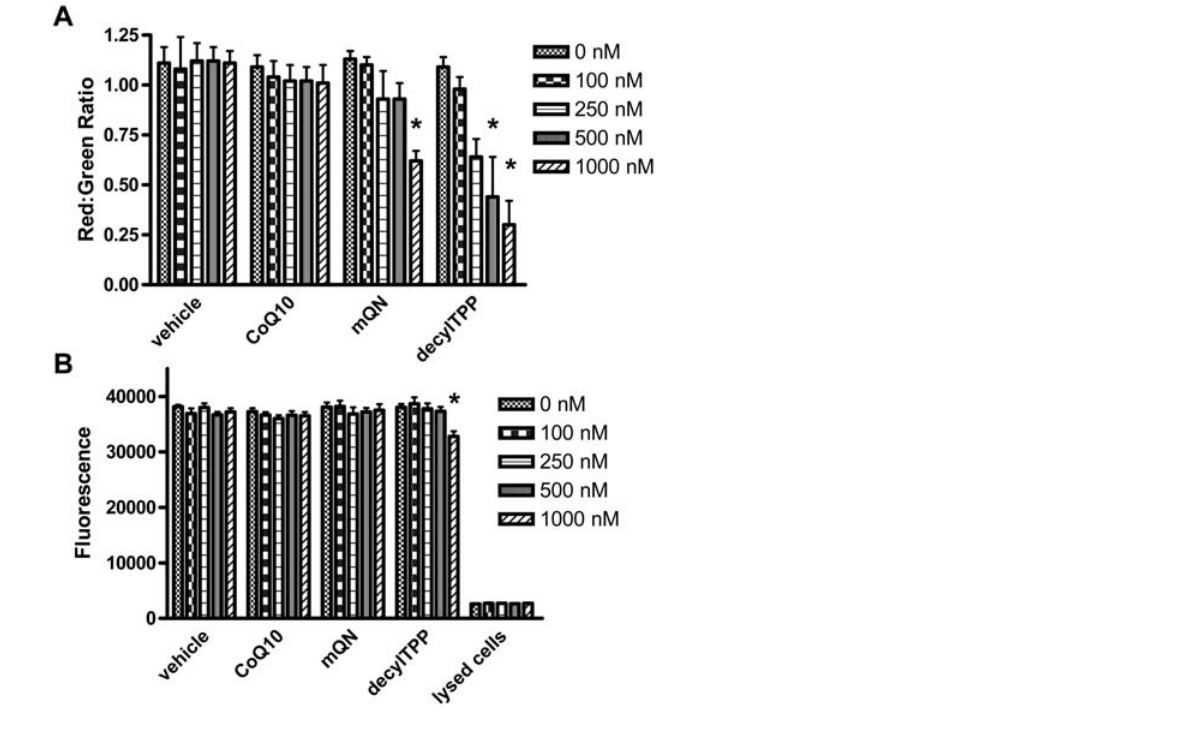
Figure 9. Dose-dependent effects of mitoquinone (mQN), CoQ10, and decylTPP on mitochondrial membrane potential in intact BAE cells and upon cell toxicity. Panel A) Membrane potential estimated as the ratio of red to green fluorescence of the potential sensitive probe, JC-1. Panel B) Cell toxicity estimated as fluorescence generated by reduction of resazurin to resorufin. For both panels, values represent mean 6 SE, n=3 for each data point, * p , 0.01 compared to the zero concentration by repeated measures ANOVA.